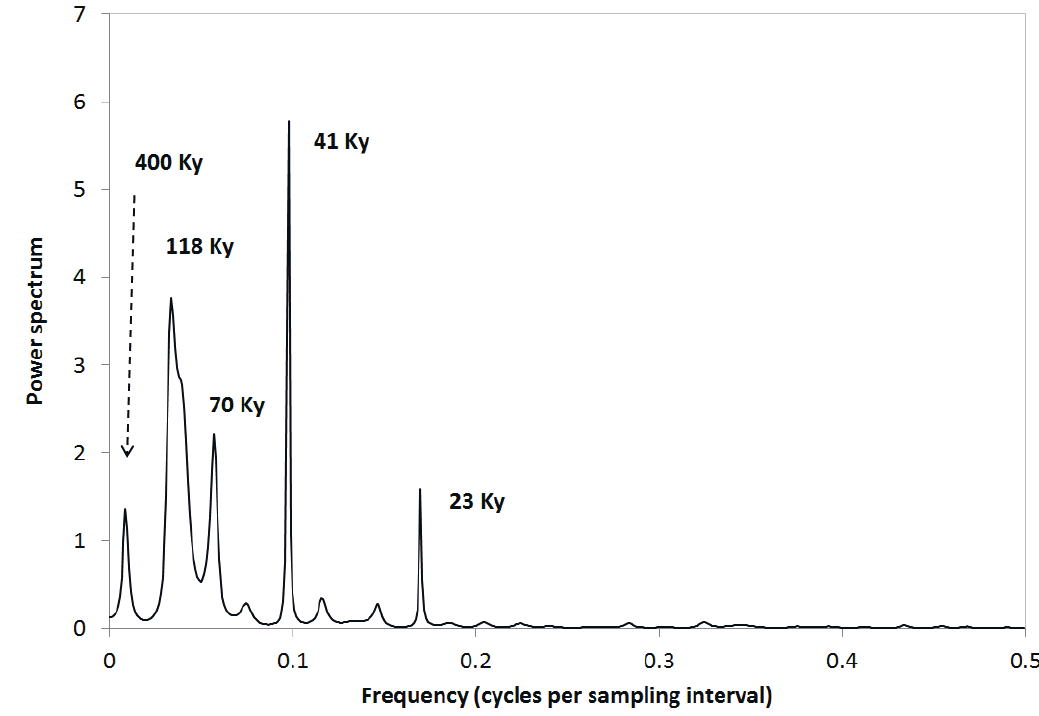
Figure 7. Power spectrum of the time series shown in Figure 6, estimated by maximum entropy (with 64 autoregressive terms). The Nyquist frequency is 0.5, which corresponds to a period of 8 Ky.